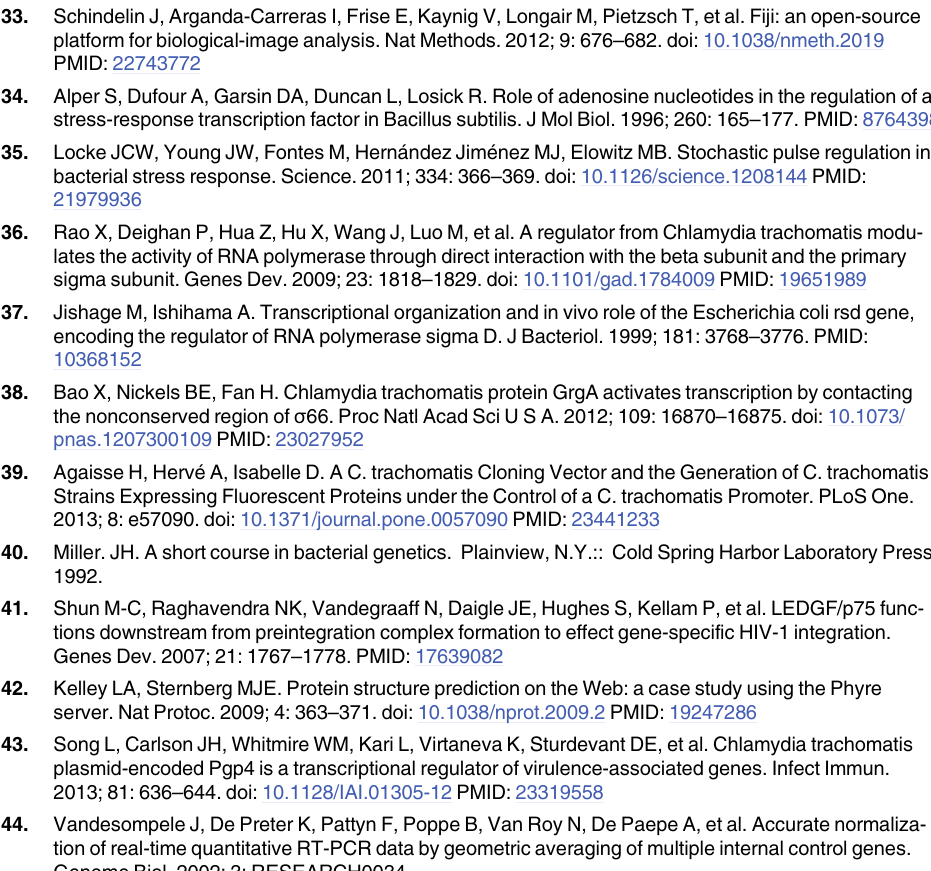
PLOS Pathogens | DOI:10.1371/journal.ppat.1005125 August 27,